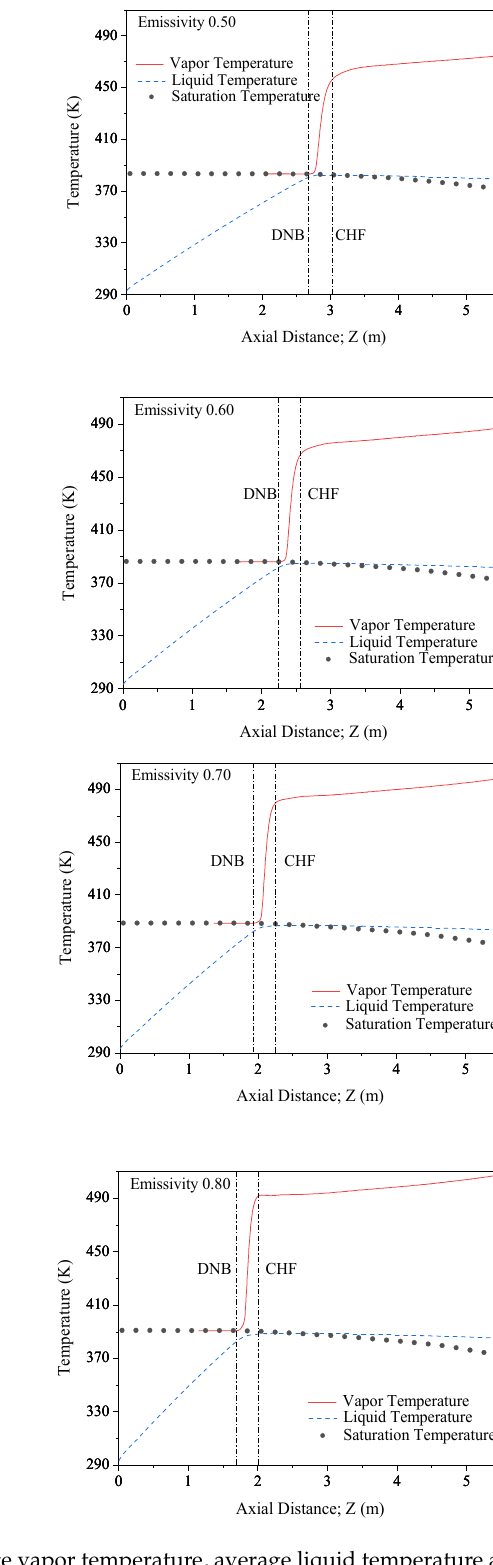
Figure 22. Distributions of average vapor temperature, average liquid temperature and local saturation temperature along the axial direction under wall emissivity ranging from 0.40 to 0.80.